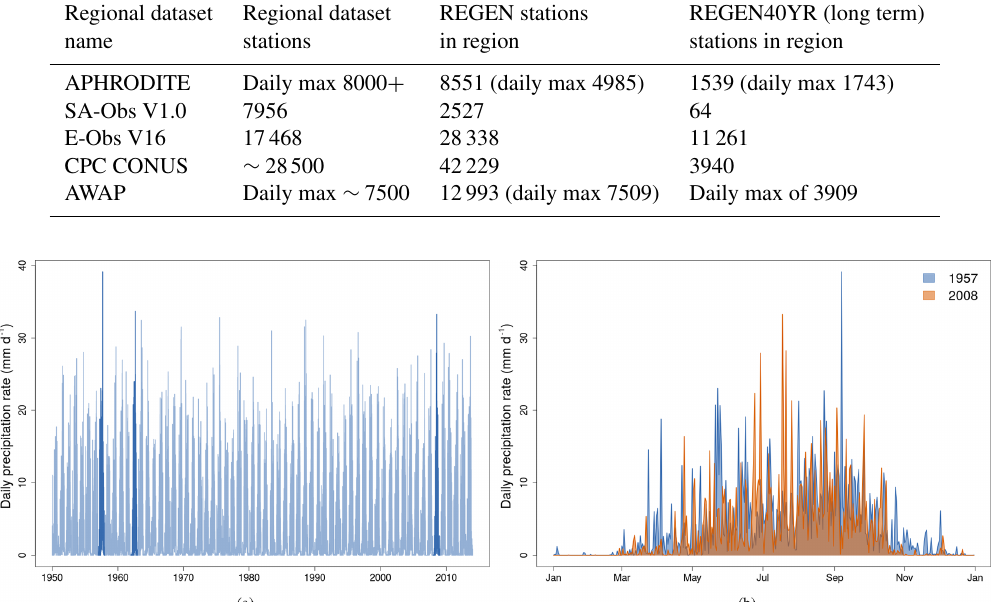
Table 1. Total number of stations interpolated by five regional datasets and the corresponding number of stations in each region interpolated by REGEN and REGEN40YR datasets over the entire time period of each respective regional dataset (CPC CONUS – 1950–2006, E-Obs V16